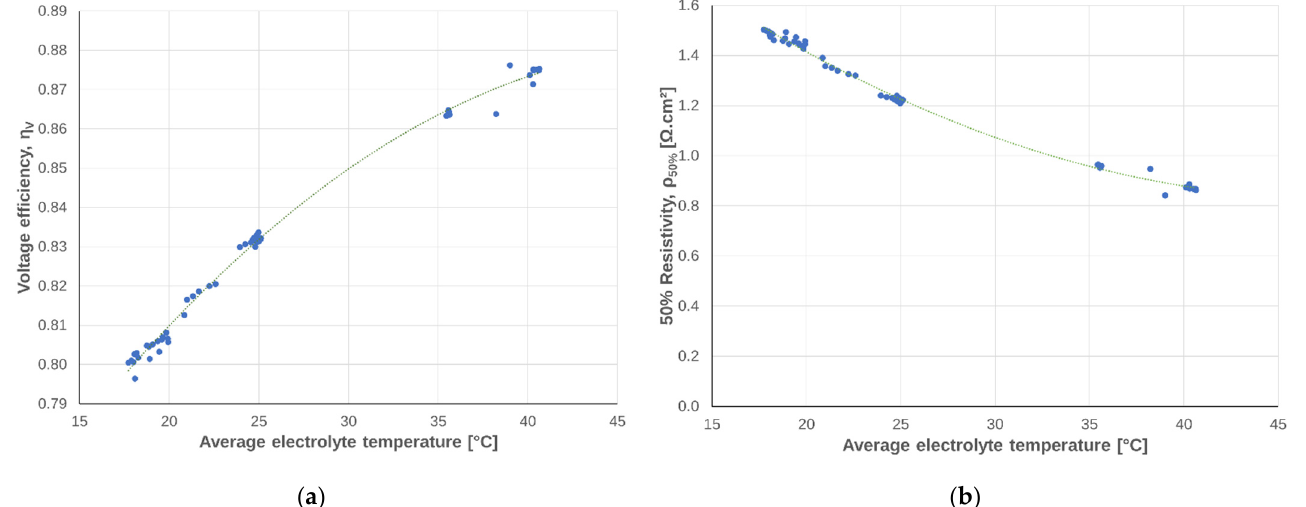
Figure 3. A vanadium redox flow cell was cycled under constant current conditions, over a range of electrolyte temperatures, from which: ( a ) voltage efficiency and ( b ) 50% resistivity were calculated for each cycle.